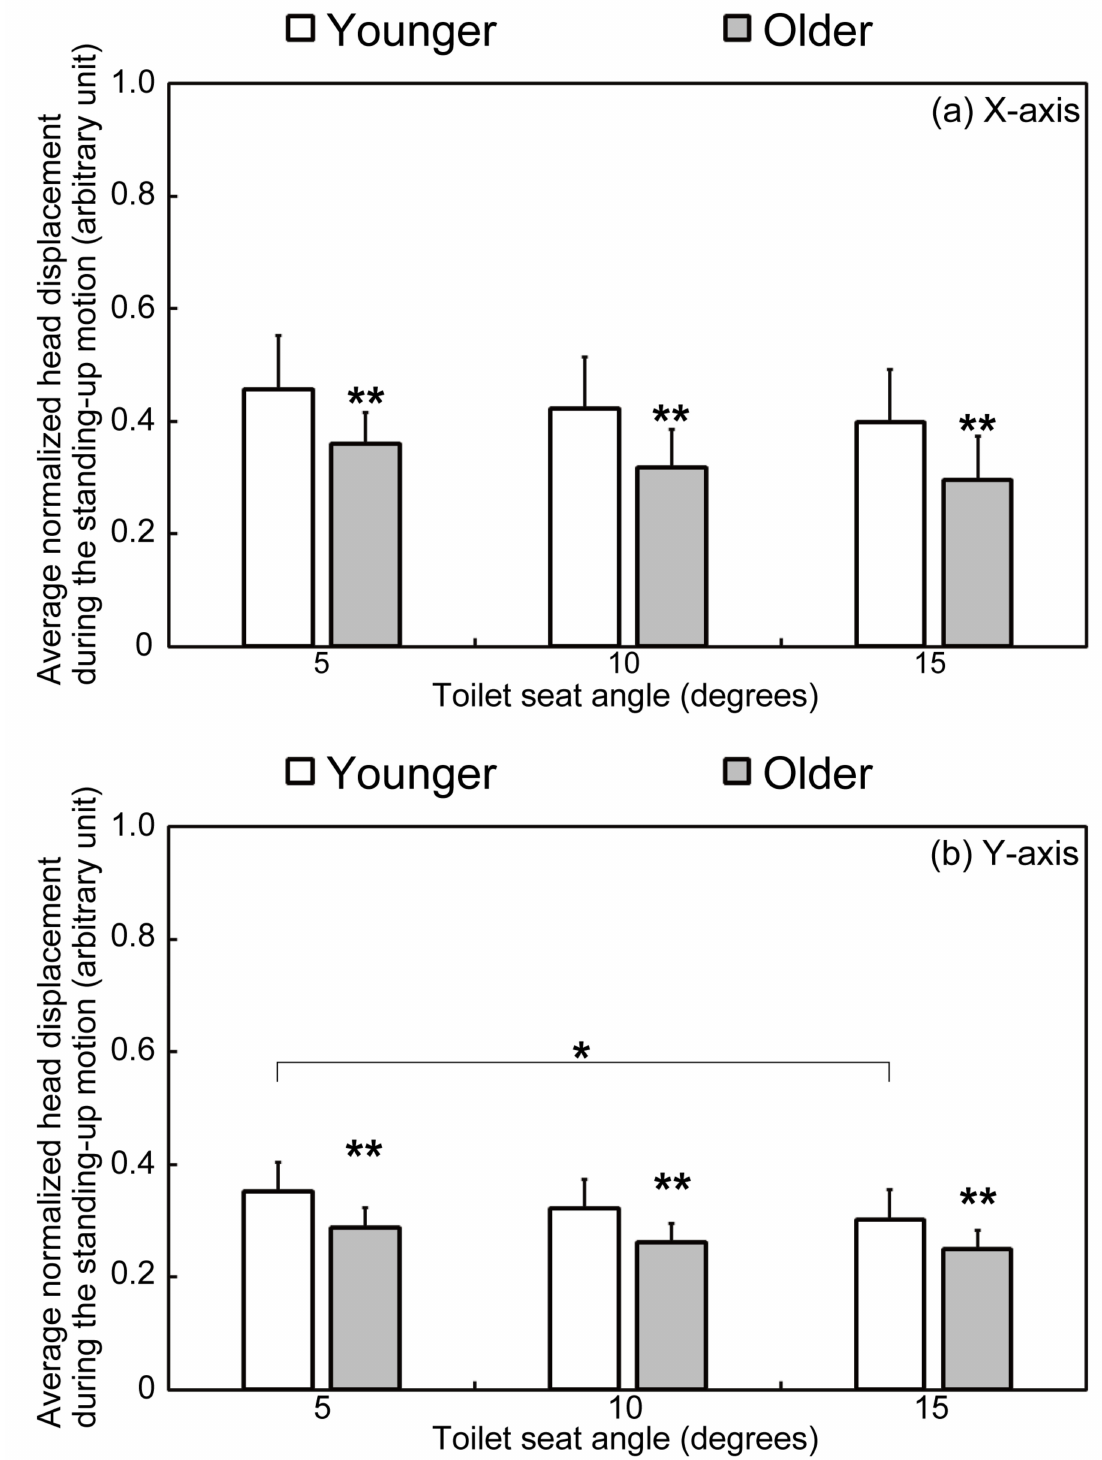
Figure 5. Average forward–backward ( a ) and up–down ( b ) head motion during the standing-up motion in the sagittal plane according to toilet seat angle, normalized by body height. Vertical lines denote the standard error of the mean. Brackets indicate a statistically significant difference (based on the Bonferroni test) by toilet seat angle. Asterisks indicate statistically significant differences (based on the Bonferroni test) between younger and older participants. Bonferroni multiple comparison test (**) p < 0.01, (*) p <